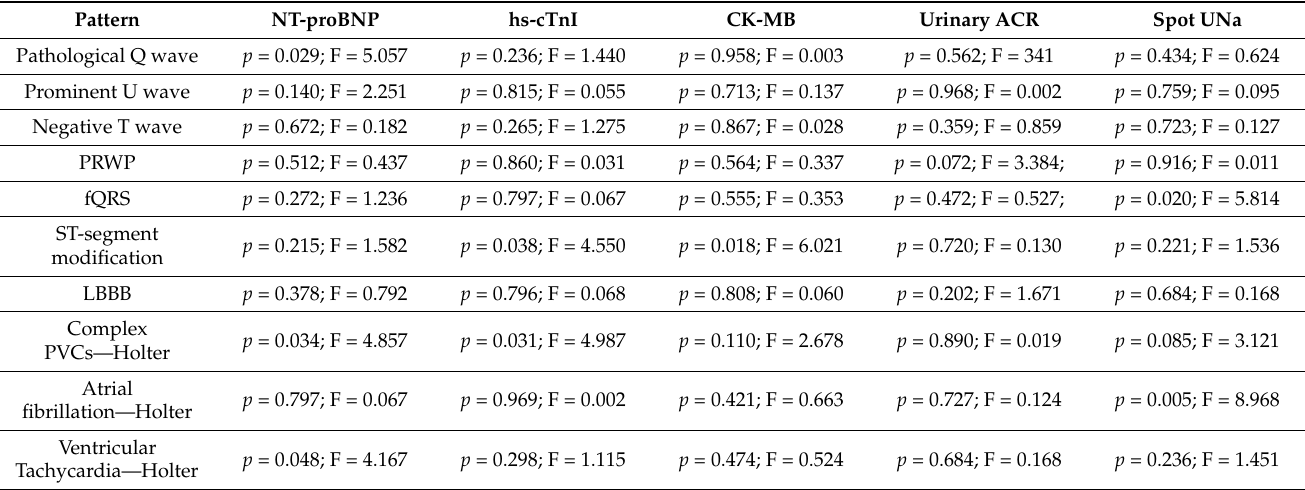
Table 12. Correlations of biomarkers with ECG and Holter patterns in patients with